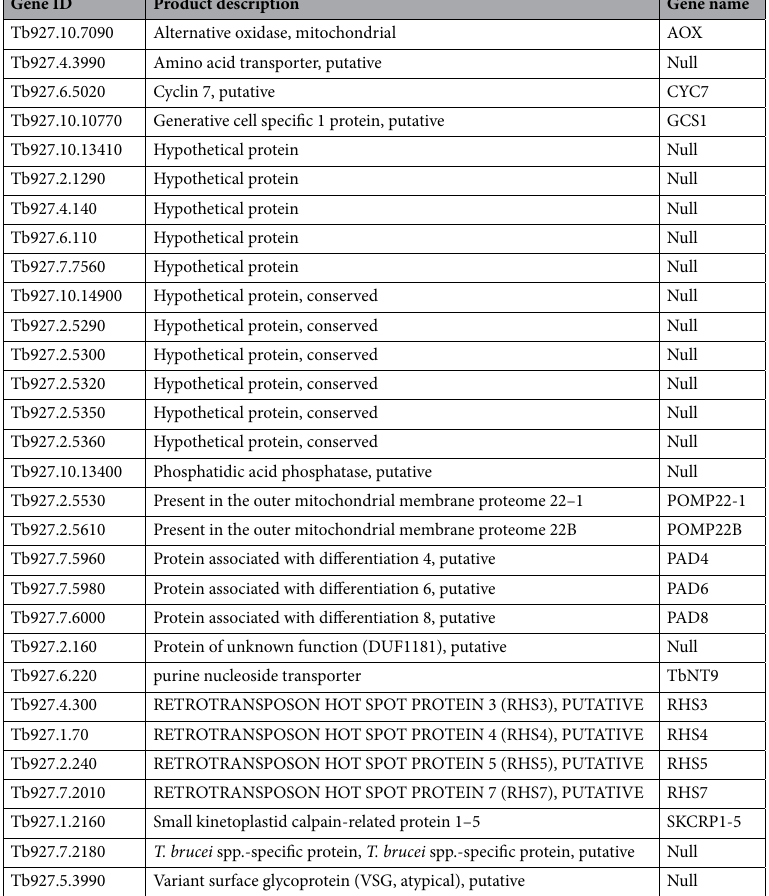
Table 3. Transcripts not affected in any of the RNAi and KO cell